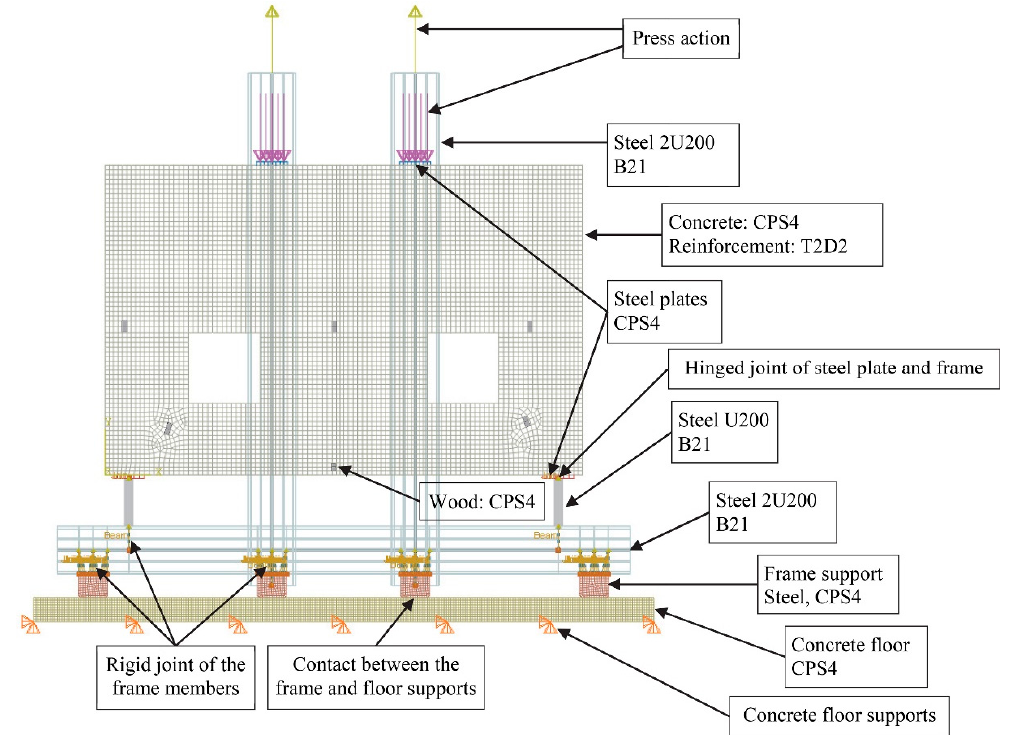
Figure 18. Model FEM B of the reinforced concrete W1 specimen with wooden spacers and the steel frame.